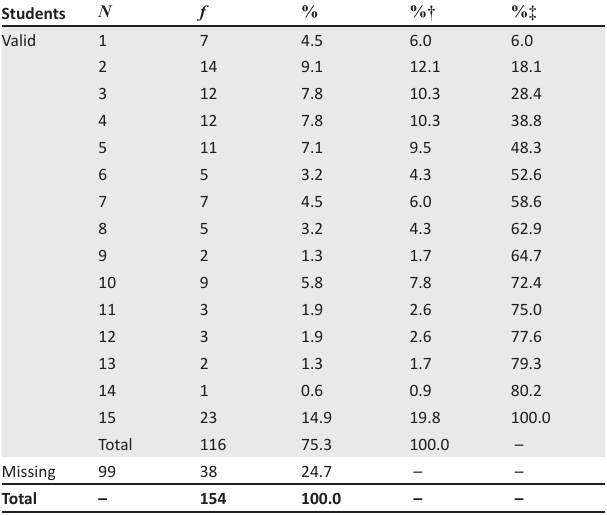
TABLE 8: Students’ performances on neonatal antiretroviral